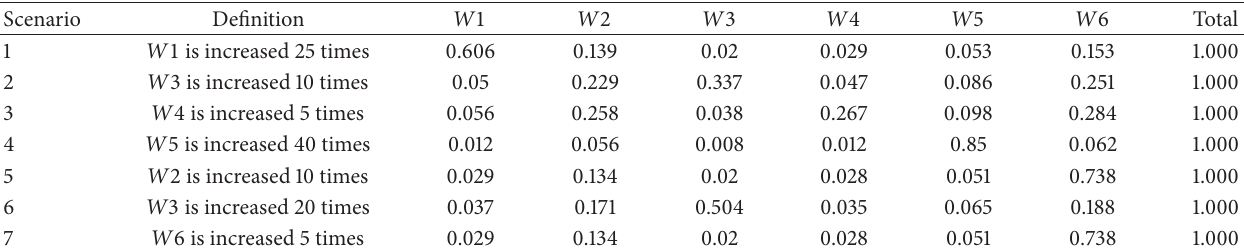
Table 12: The weights of each criterion for each scenario.